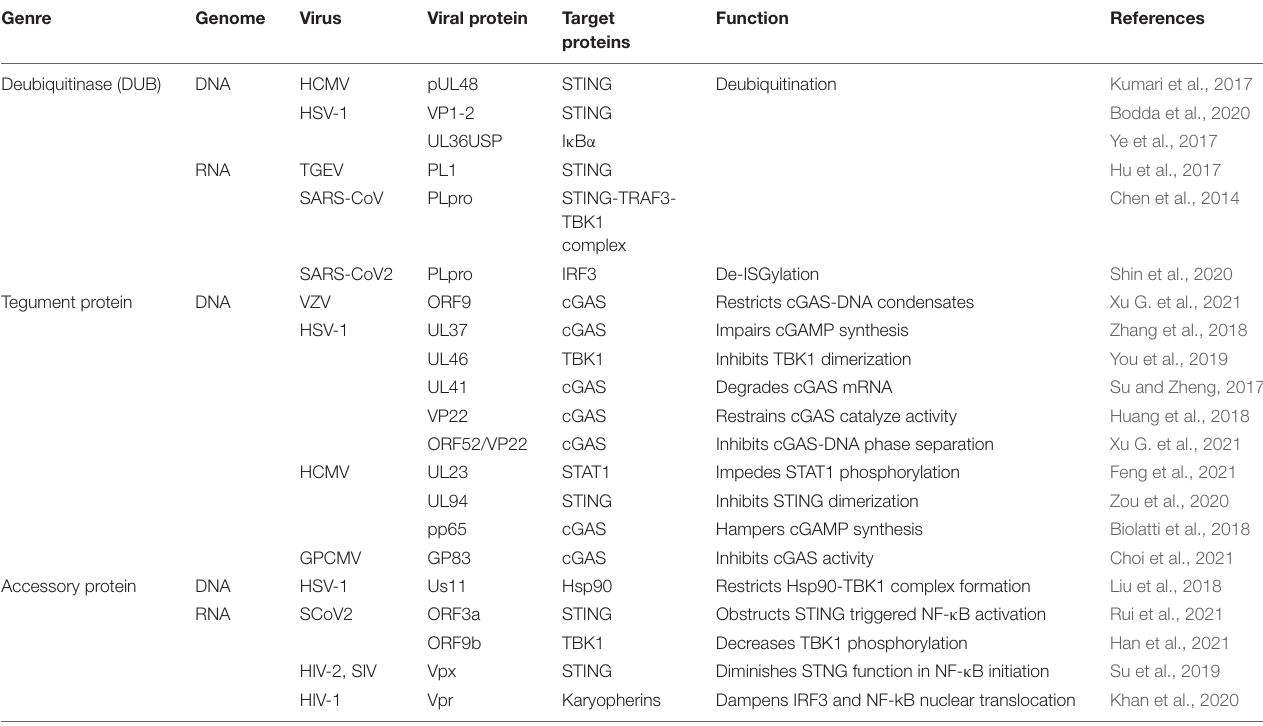
TABLE 5 | Viral proteins involved in cGAS-STING cascade